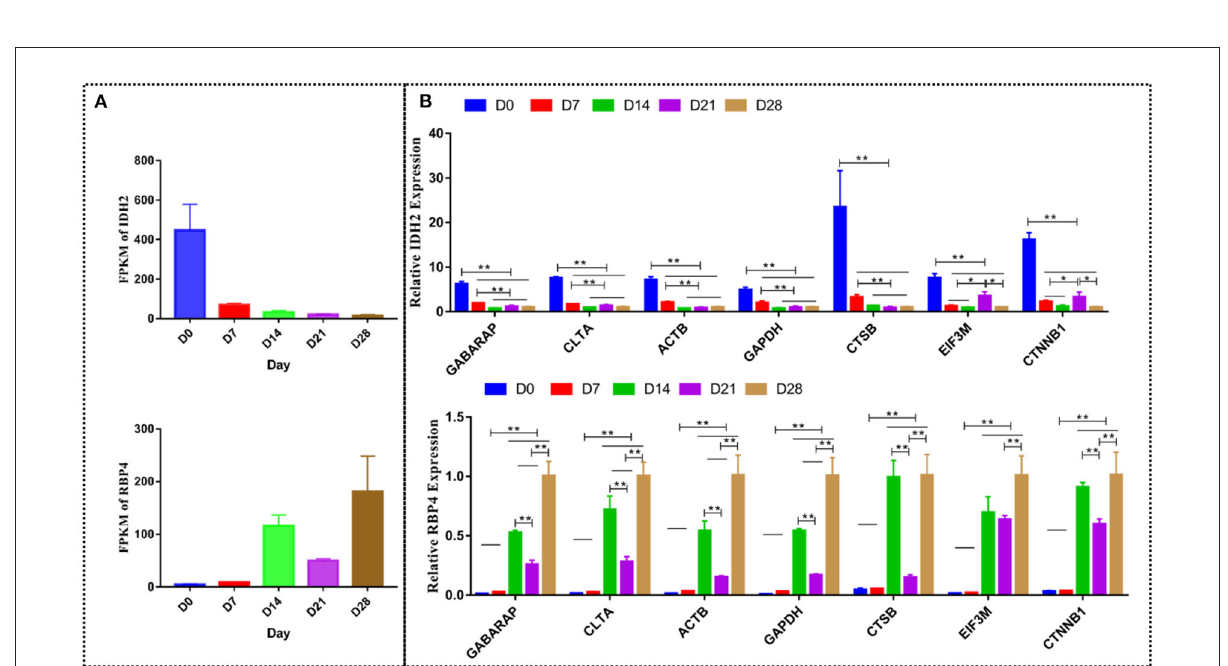
FIGURE10 The relative expression of IDH2 and RBP4 normalized by different reference genes. (A) The mRNA expression level measured by RNA-seq. (B) The expression of IDH2 and RBP4 was normalized using GABARAP , CLTA , ACTB , GAPDH , CTSB , EIF3M , and CTNNB1 genes. * p < 0.05; ** p <